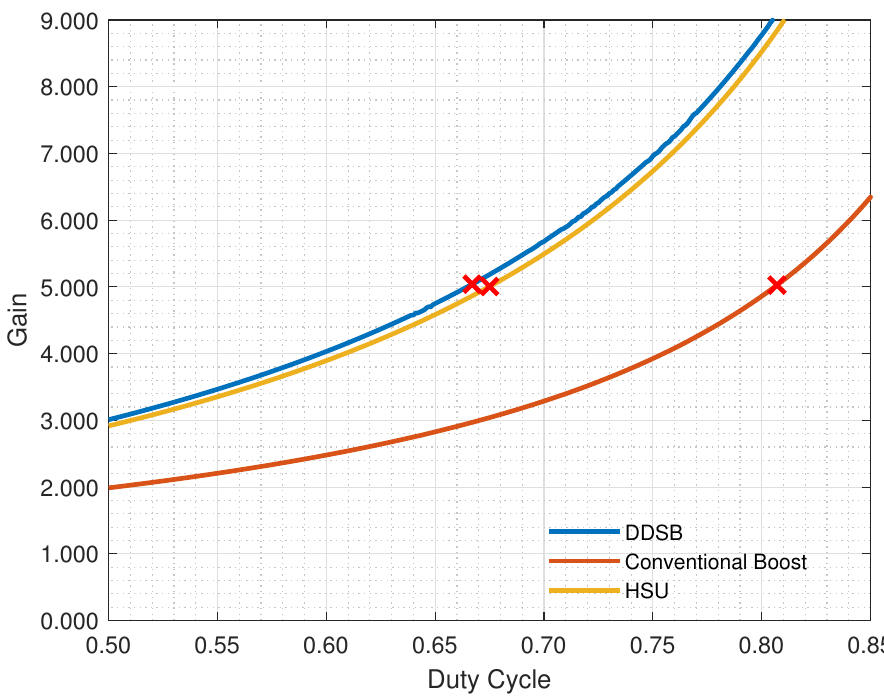
Figure 8. Comparison of the gain ratio of the conventional boost and HSU vs. DDSB power